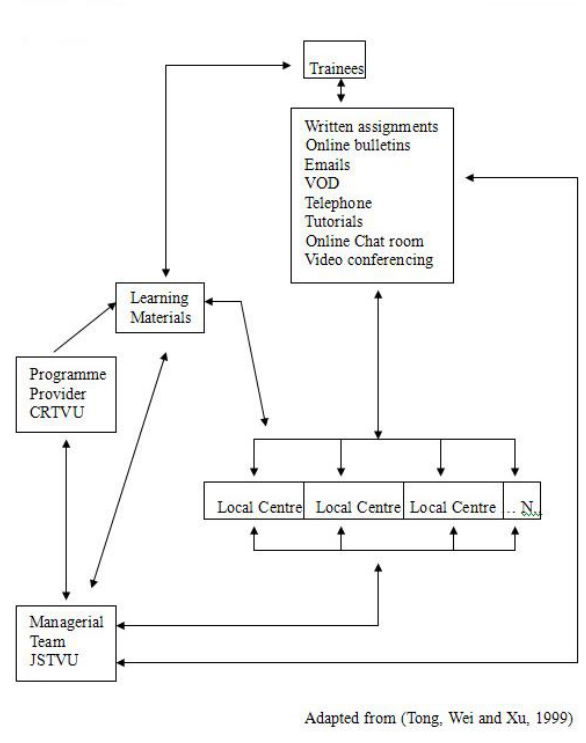
Figure 2. Model of implementation of integratration with High-technology and Low-technology